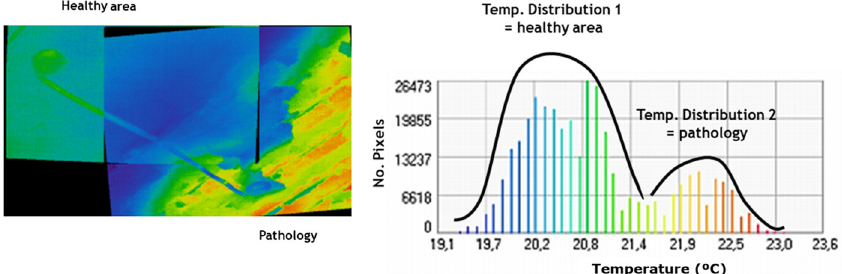
Figure 3. Example of pseudobimodal temperature distribution presented by thermographic images where a pathology is present.